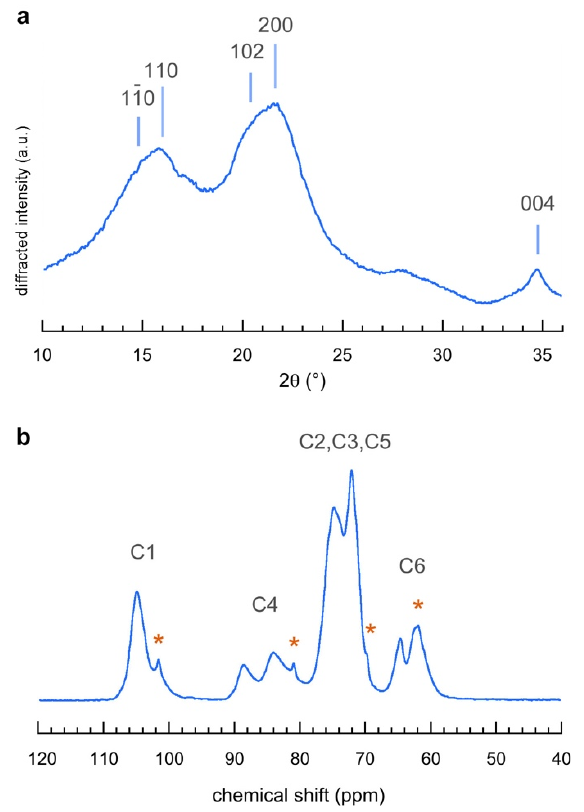
Figure 3. ( a ) X-ray powder diffraction pattern, and ( b ) CP/MAS 13 C-NMR spectrum of the extracted nanocellulose (ENC). In ( a ), the Miller indices correspond to those of cellulose I β [33] . In ( b ), the asterisks indicate the presence of a minor fraction of residual mannan I in the ENC sample (Figure S3). * means other significant peaks.